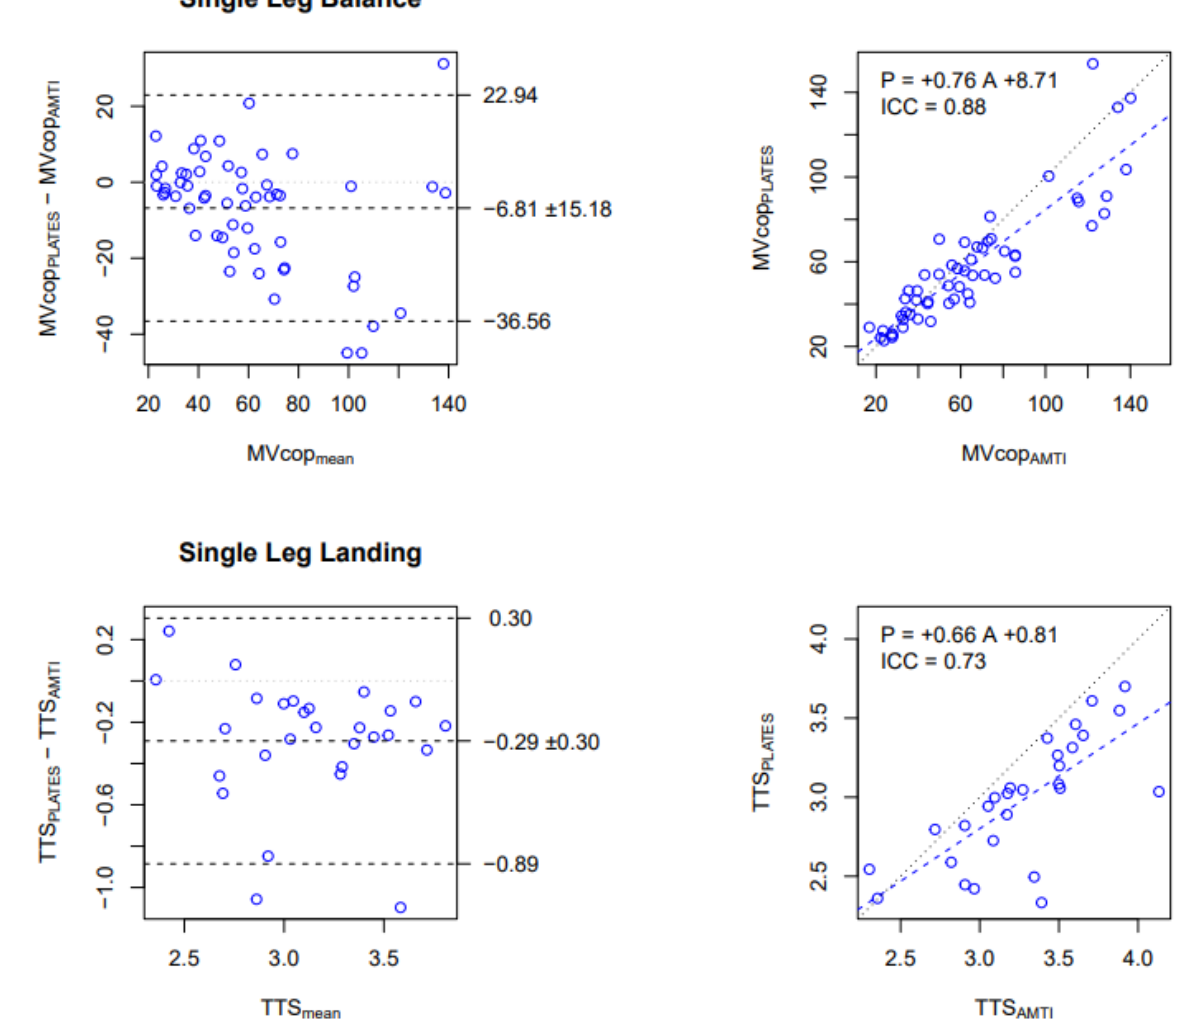
Figure 2. Comparison of MVcop and TTS obtained with the PLATES vs. AMTI in the Laboratory. Upper row: MVcop for the Single Leg Balance test (mm/s). Lower row: TTS for the Single Leg Landing test (s). Left column: Bland and Altman plot. The central horizontal line indicates the mean of the differences (systematic bias), which is 0 for perfect agreement. The horizontal lines above and below represent the 95% limits of agreement. Right column: Linear regression. Data from all conditions are reported (i.e., 14 participants × 4 conditions for SLB, 14 participants × 2 conditions for SLL). Each dot corresponds to the average over the 3 repetitions in each condition. The figures show that MVcop and TTS are reliably assessed in the laboratory with PLATES, although with a small underestimation (negative bias in Bland and Altman) that is proportional to the value (slope lower than 1 in the